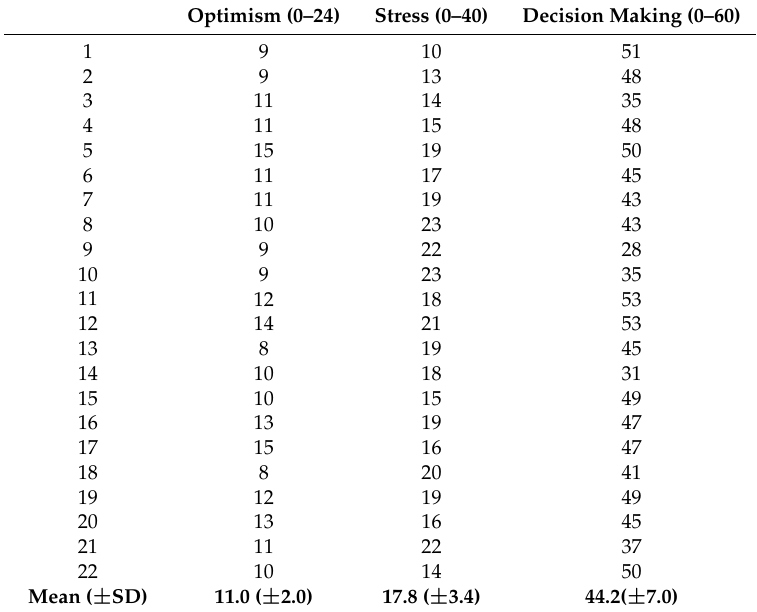
Table 2. Individual total and group mean ( ± SD) psychological